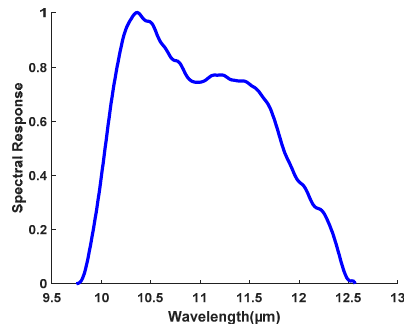
Figure 3. Spectral response for band 5 of FY-3C/MERSI.